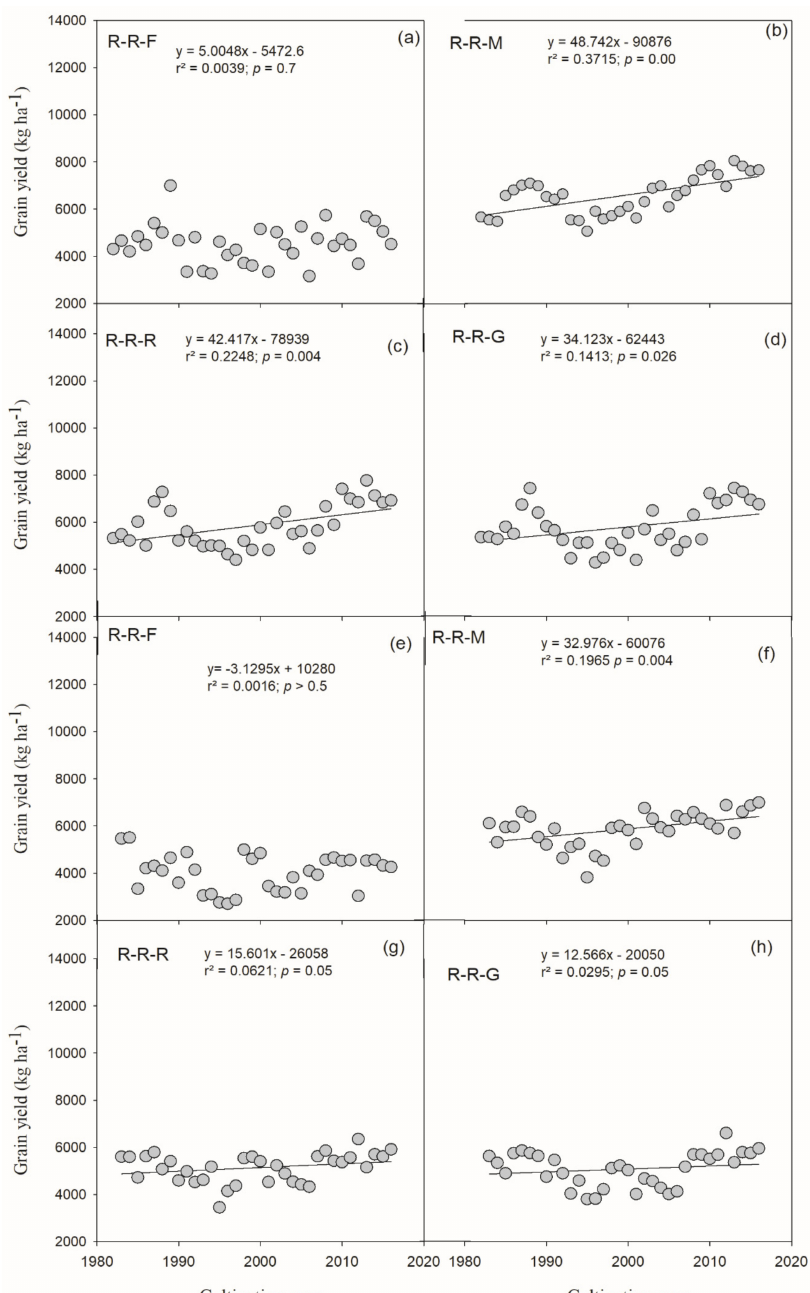
Figure 1. Linear regression showing trends of rice grain yields over the years (1982–2016) under green manure rotations in the rice-based cropping